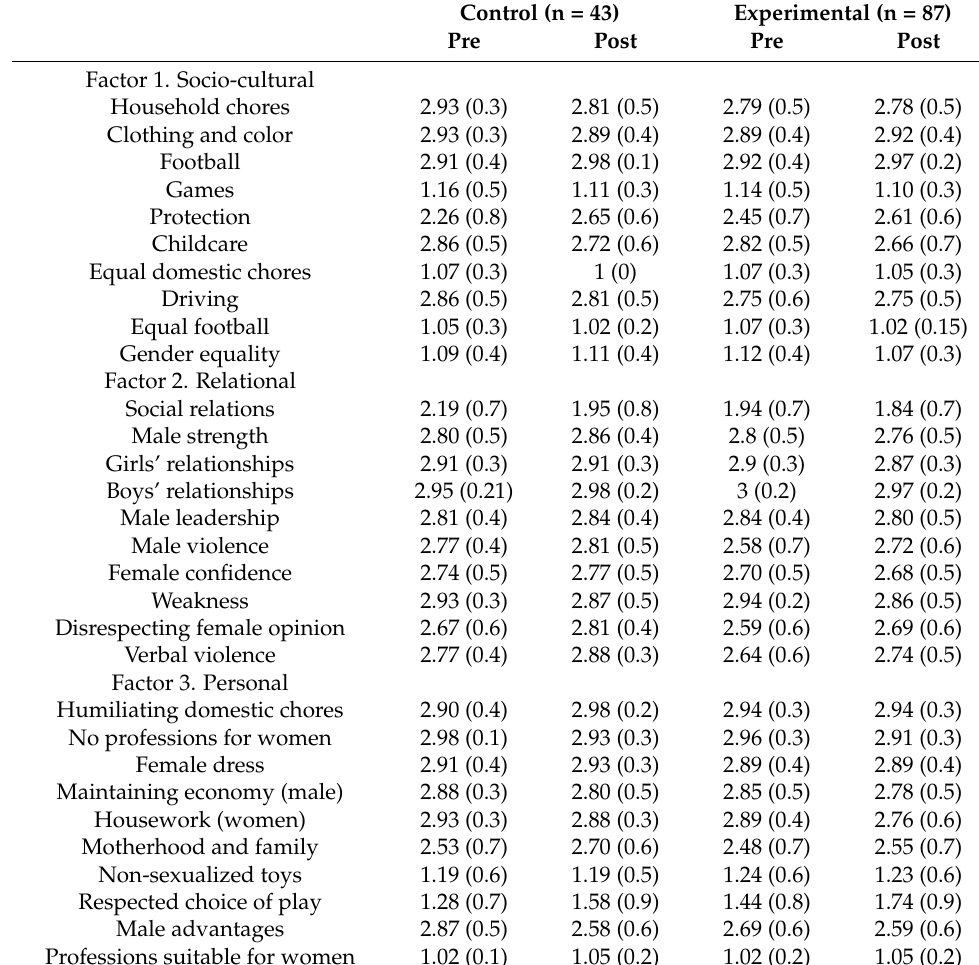
Table 1. Descriptive analysis for the questionnaire on attitudes towards gender equality among primary school